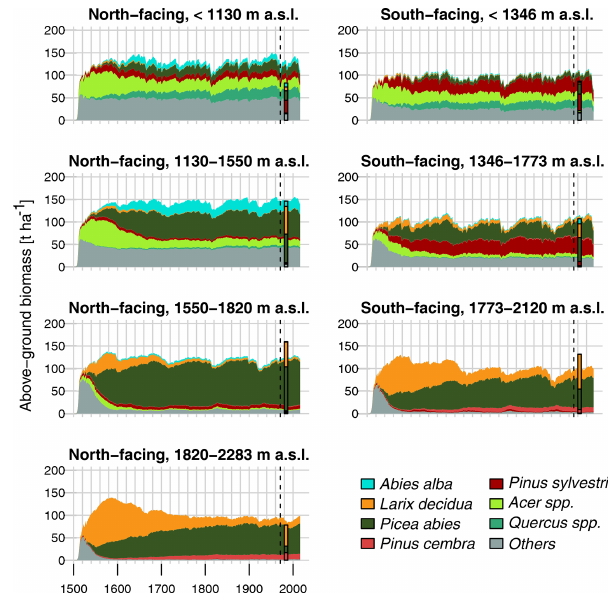
Figure 6. Above-ground tree biomass simulated with FORHYCS using the configuration S_noLAred (Table 1). The graphs show an- nual values, averaged over seven clusters of cells. The bar shows the above-ground biomass in the same area, from the first Swiss national forest inventory (1982–1986; Bachofen et al., 1988). The limits of the elevation bands were set so that each cluster con- tains at least 30 forest inventory plots. The dashed line marks the year 1971, from when meteorological data are available. Simula- tion years before 1971 use meteorological data bootstrapped from the years